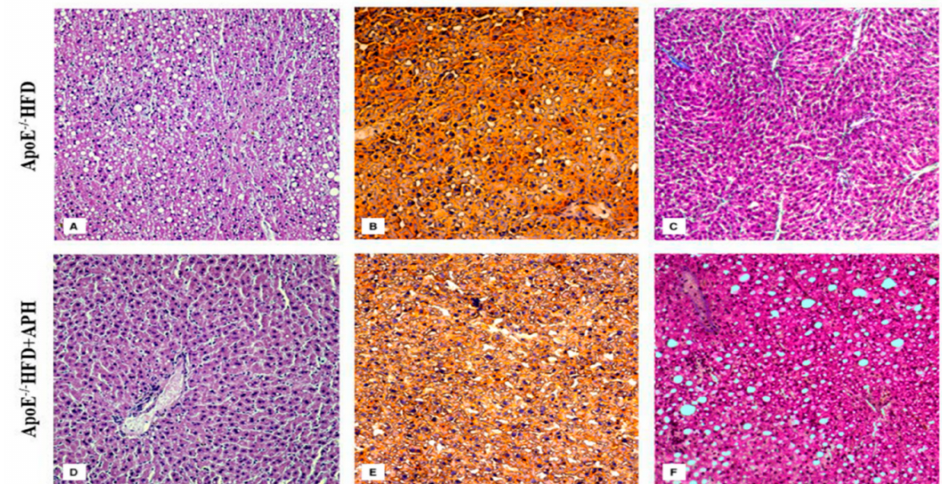
Figure 4. Hepatic histology. Representative liver sections of H&E ( A , D ) Oil Red O ( B , E ) and Mallory’s Trichrome ( C , F ) histological staining of ApoE – / – mice included in both groups (Scale bar, 100 µ m). Abbreviations: HFD high-fat diet, APH anchovy protein hydrolysates.